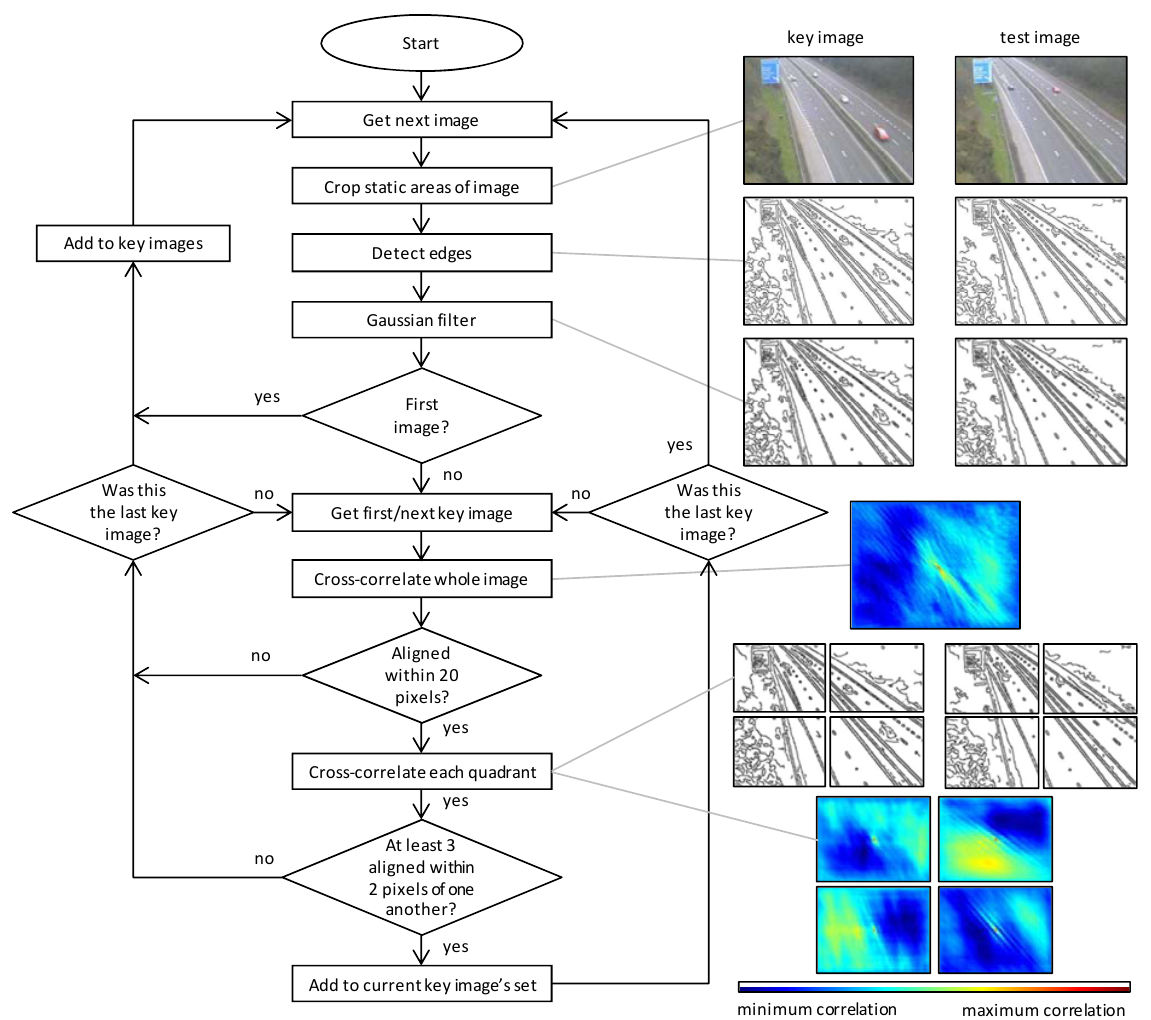
Figure 2. Flow-chart describing the image collection and alignment process, along with example images output at different stages of the